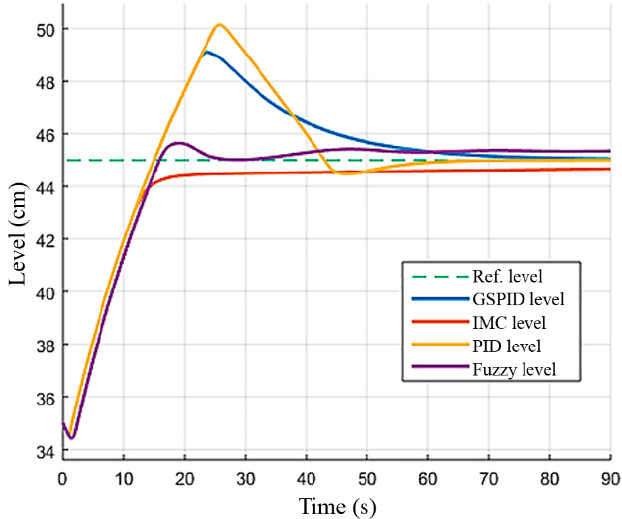
Figure 12. Controller’s response to a 35 to 45 cm reference step. Figure 10. Controller’s response to a 35 to 45 cm reference step. test scenarios are detailed below.